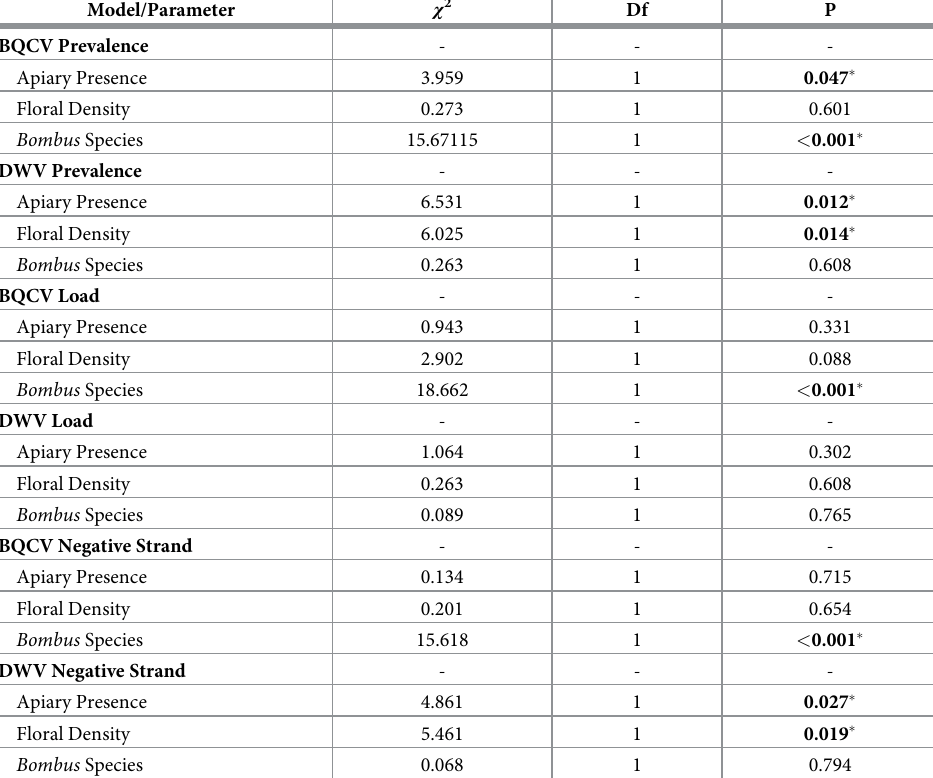
Table 2. Results of the GLMMs showing each model and the fixed effects tested. Table shows chi squared value, degrees of freedom (Df) and p-value. Apiary presence refers to whether the site had a commercial apiary present or no apiary nearby. Floral density was calculated as the number of inflorescences per m 2 . Bee species was either Bombus bimaculatus or B . vagans . Asterisks ( � ) represent